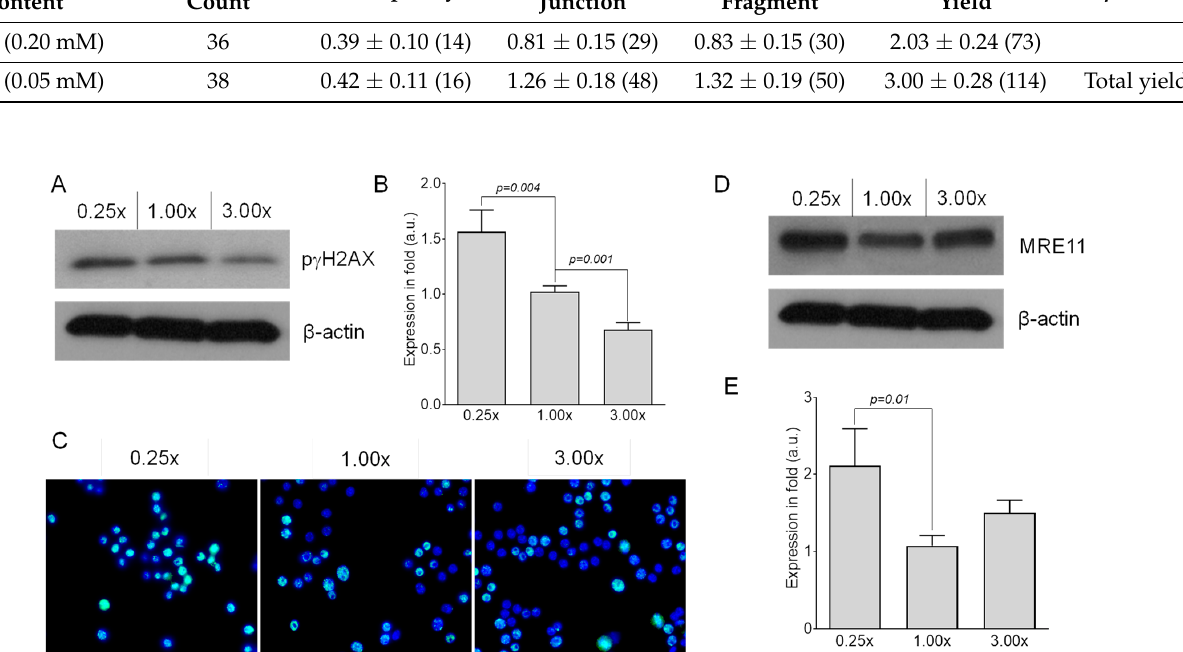
Figure 4. Effects of methionine on radiation-induced genetic damage. ( A ) Representative Western blot analysis and ( B ) quantitation of phosphorylated γ H2AX protein, a marker of DNA double-strand breaks, in RAW 264.7 cells grown in either methionine-deficient (0.25×) or adequate (1.00×) or supplemented (3.00×) media for 1 month followed by 2 Gy radiation exposure ( n = 3). β -actin served as a loading control. n , number of independent experiments performed. ( C ) Representative photomicrograph (20 × magnification) showing immunofluorescence of γ H2AX foci (green) in RAW 264.7 cells grown in either methionine-deficient (0.25×) or adequate (1.00×) or supplemented (3.00×) media for 1 month followed by 2 Gy radiation exposure ( n = 3). Nuclei were stained with DAPI (blue). ( D ) Representative Western blot analysis and ( E ) quantitation of MRE11 protein in RAW 264.7 cells grown in either methionine-deficient (0.25×) or adequate (1.00×) or supplemented (3.00×) media for 1 month followed by 2 Gy radiation exposure ( n = 3). β -actin served as a loading control. n , number of independent experiments performed. Cells were harvested 4 h after irradiation in these experiments.